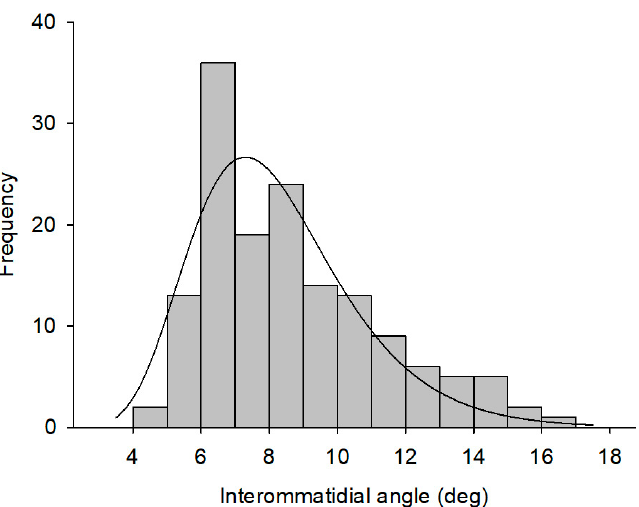
Figure 7. Frequency distribution diagram of interommatidial angles from the behavioral experiment. The x-axis is the frequency distribution of interommatidial angles with the same interval. The fitting curve (log normal, 3 parameter) was obtained using SigmaPlot (V11.0).